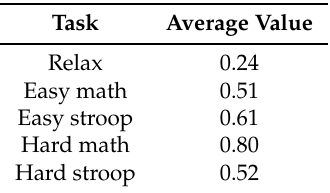
Table 2. Average normalized visual analogue scale (VAS) scores for all tasks. These have been normalized to a range of 0–1 with a MinMax scaler.